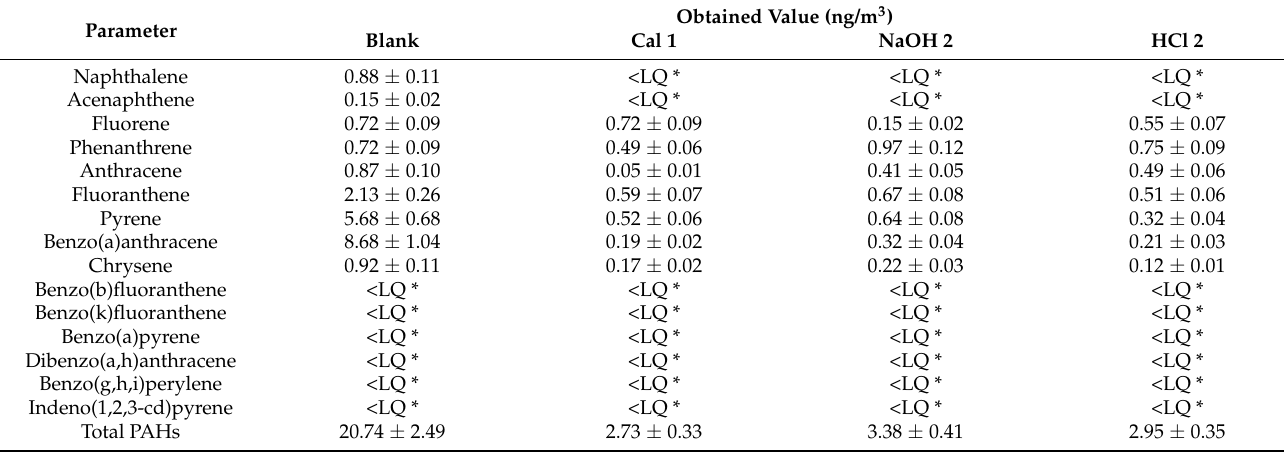
Table 8. Results for samples taken on cotton buds.